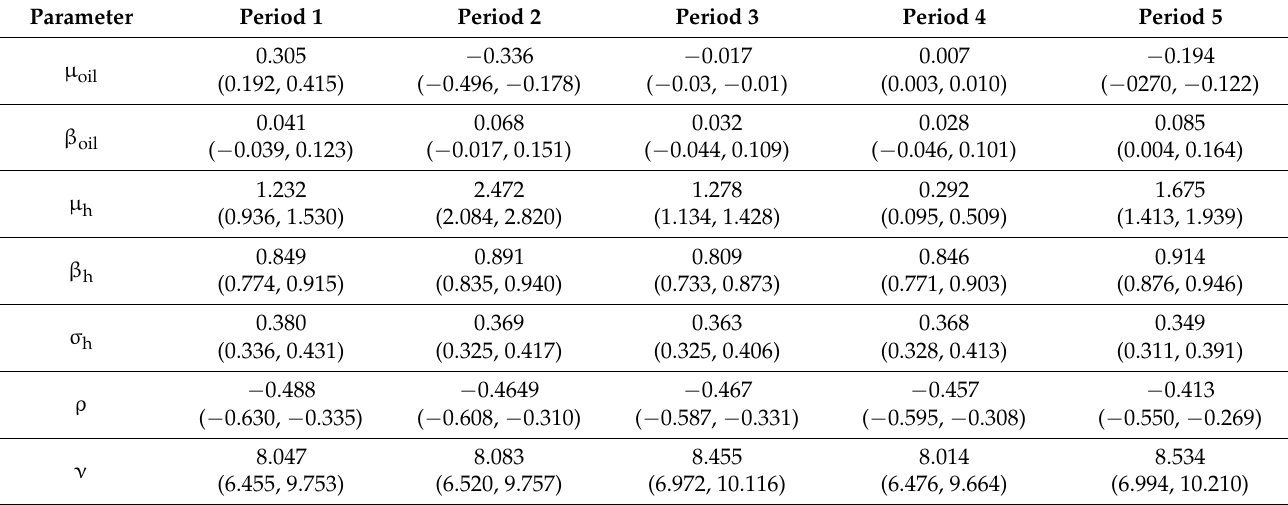
Table A1. Estimates of mean and standard deviation of